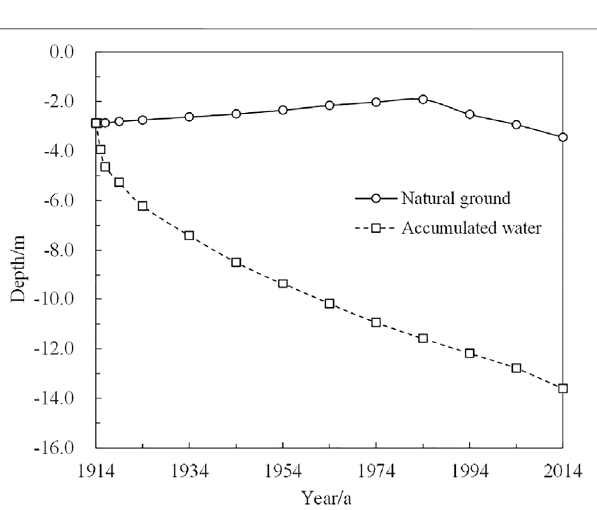
FIGURE 8 | Comparison of the thaw depth for the natural ground and the permafrost underlying accumulated water body during the calculation